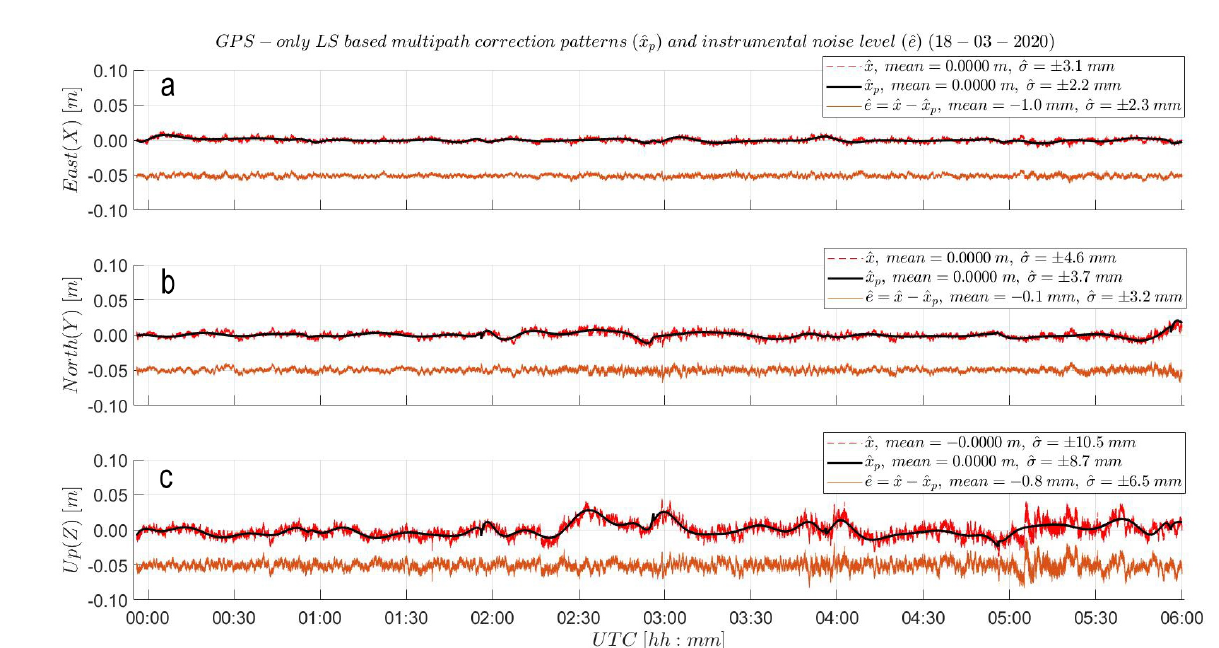
Figure A4. ( a ) East, ( b ) North and ( c ) Up LS-based MP correction ( ˆ x p , black curves) of a six hour fragment of (ENU) baseline time series of day 078 (bright red) and the resulting GNSS empirical noise (ˆ e ) level (red) post subtraction of LS polynomial curves. For visualization purposes, the ENU noise sequences are shifted by 5 cm. Resulting ENU instrumental noise time series show a variability (ˆ σ ) of ± 2.3, 3.2 and 6.5 mm, respectively. The noise sequences present an almost random behavior freed from MP harmonic behavior. The start and end is corresponding to 18 March 2020 23:52:08 and 06:00 UTC.